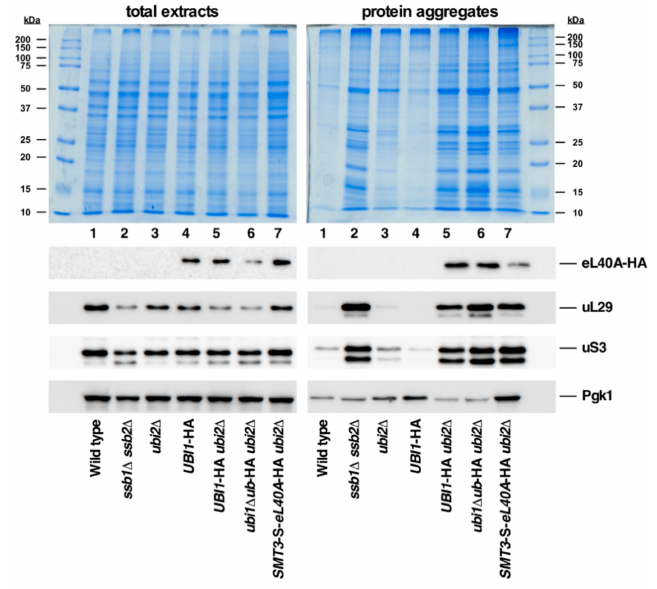
Figure 8. Analysis of protein aggregation in ubi1 ∆ ub -HA and SMT3-S-eL40A -HA cells. Strains W303-1A (Wild type), JDY532 ( ssb1 ∆ ssb2 ∆ ), JDY923 ( ubi2 ∆ ), SMY113 ( UBI1 -HA), SMY256 ( UBI1 -HA ubi2 ∆ ), SMY257 ( ubi1 ∆ ub -HA ubi2 ∆ ), and SMY258 ( SMT3 - S - eL40A -HA ubi2 ∆ ) were grown to logarithmic phase in YPD